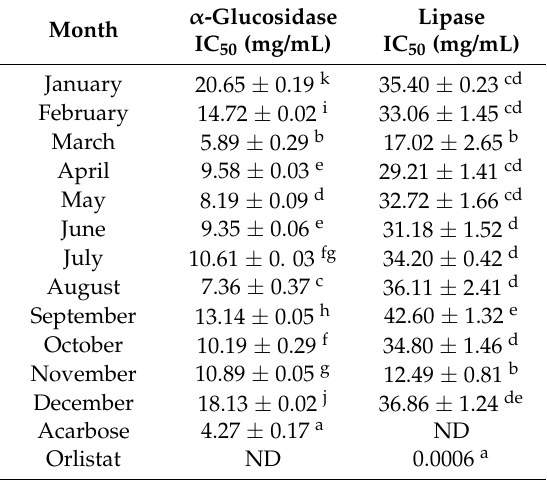
Table 5. Results of inhibition on α -glucosidase and lipase. α -Glucosidase Month IC 50